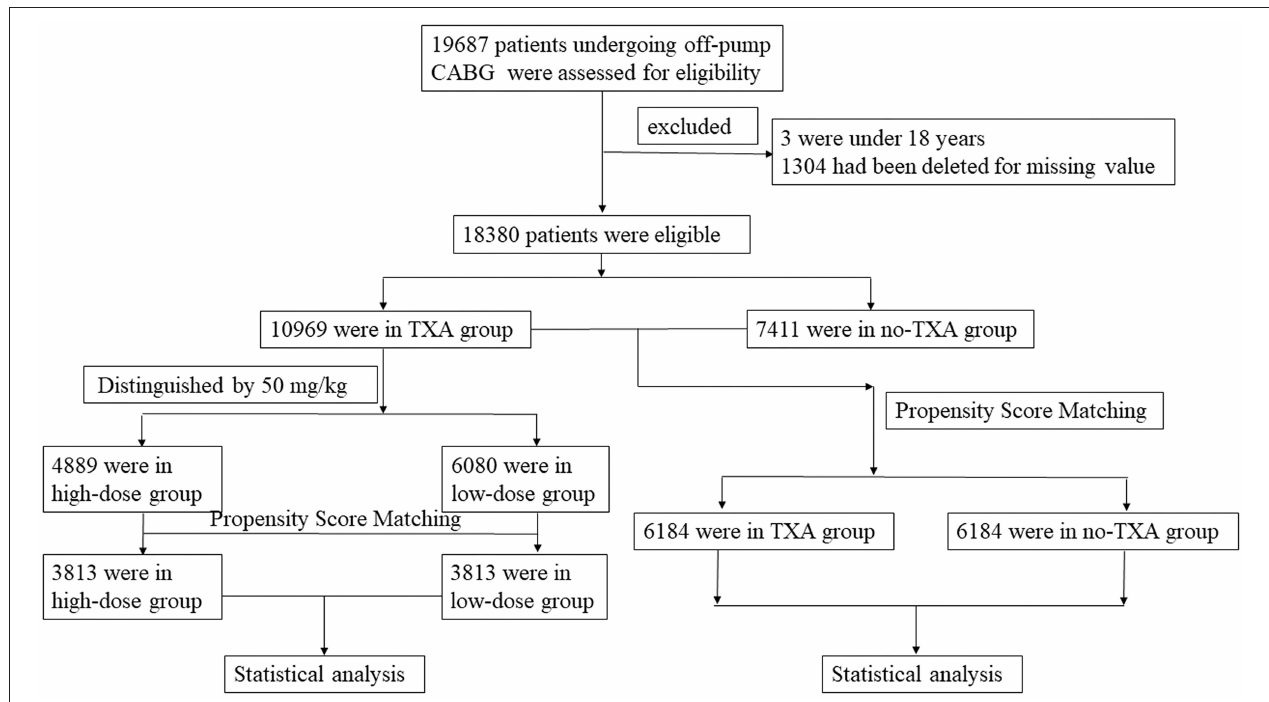
FIGURE 1 | Flowchart of OPCAB patients with or without TXA administration. This study included 19,687 patients who underwent OPCAB. Patients under 18 years old or with missing values were excluded from this cohort. A total of 18,380 OPCAB patients were finally included in this study. Among them, 10,969 patients were in the TXA group and 7,411 patients were in the no-TXA group. There were 4,889 patients whose TXA dose was ≥ 50 mg/kg, and the remaining 6,080 patients had a TXA dose of < 50 mg/kg. Propensity score matching was performed in the TXA and no-TXA groups and the high-dose and low-dose groups. A statistical analysis was